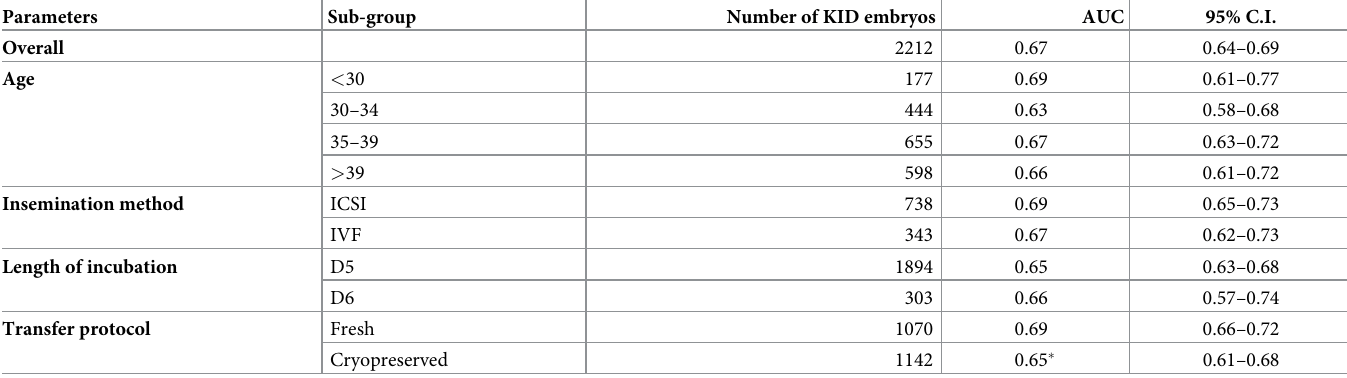
Table 3. Number of transferred embryos with known implantation data (KID), area under the curve (AUC) and 95% confidence intervals (C.I.) for the following sub-groups: age, insemination method, length of incubation and fresh vs cryopreserved embryo transfer.